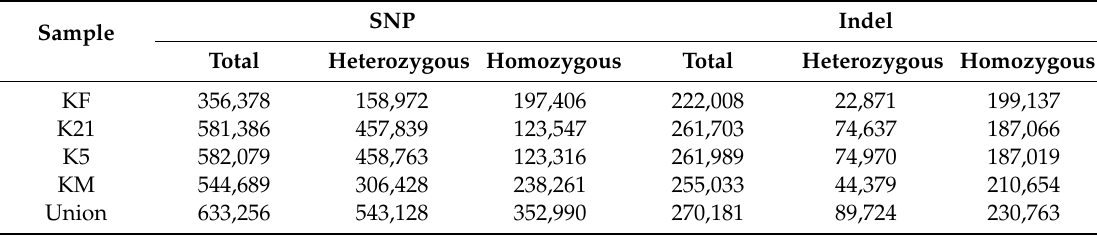
Table 4. Summary of SNPs and indel between sample and